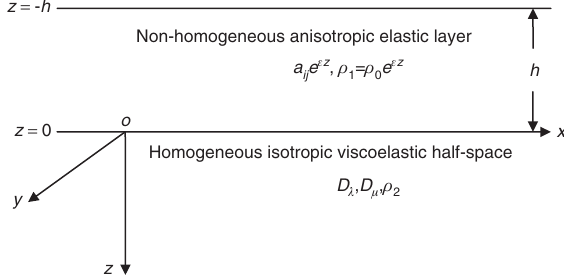
Figure 1 Geometry of the